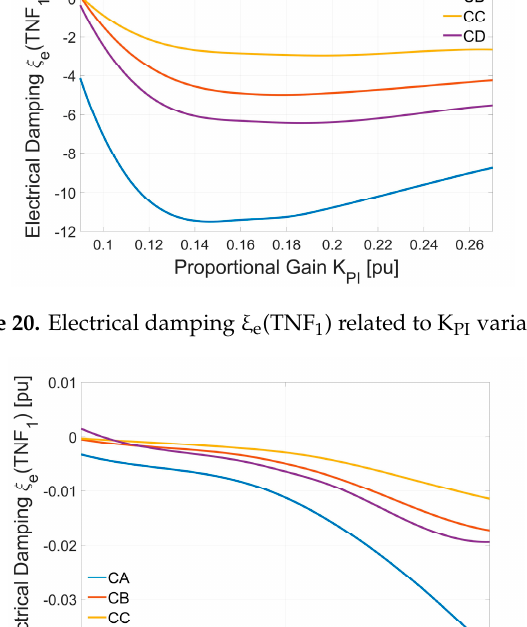
19 of 25 Figure 21. Electrical damping ξ e (TNF 1 ) related to K PLL variations. Figure 23. Electrical damping ξ e (TNF 1 ) related to K PSS variations.